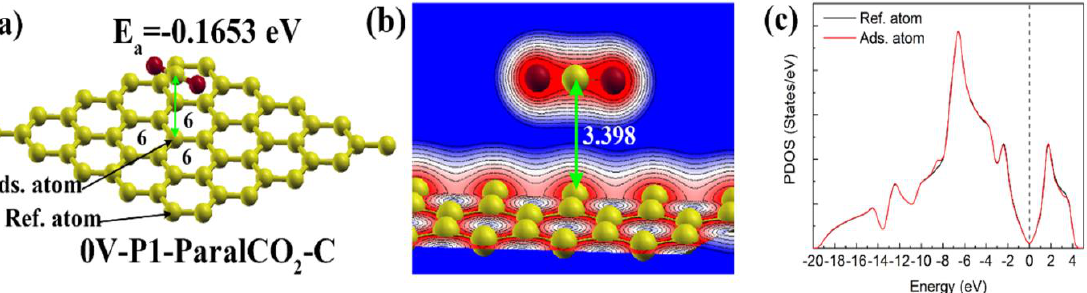
Figure 6. Physisorption configuration of CO 2 on pristine (0V) graphene: ( a ) atomic structure; ( b ) charge distribution; ( c ) PDOS graph for the 2p orbital of reference carbon atom and adsorption carbon atom. The Fermi level is represented by the dashed vertical line.